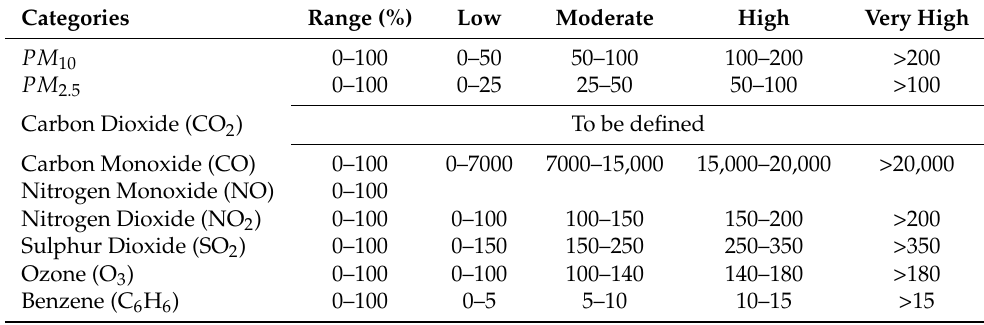
Table 8. Gas emissions observed.